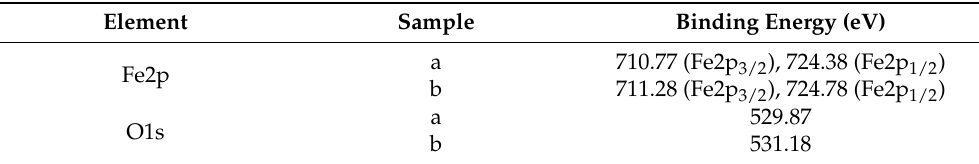
Table 5. Binding energies of various elements in ( a ) Rusted Steel with AR and ( b ) Rust conver- sion Substrate.